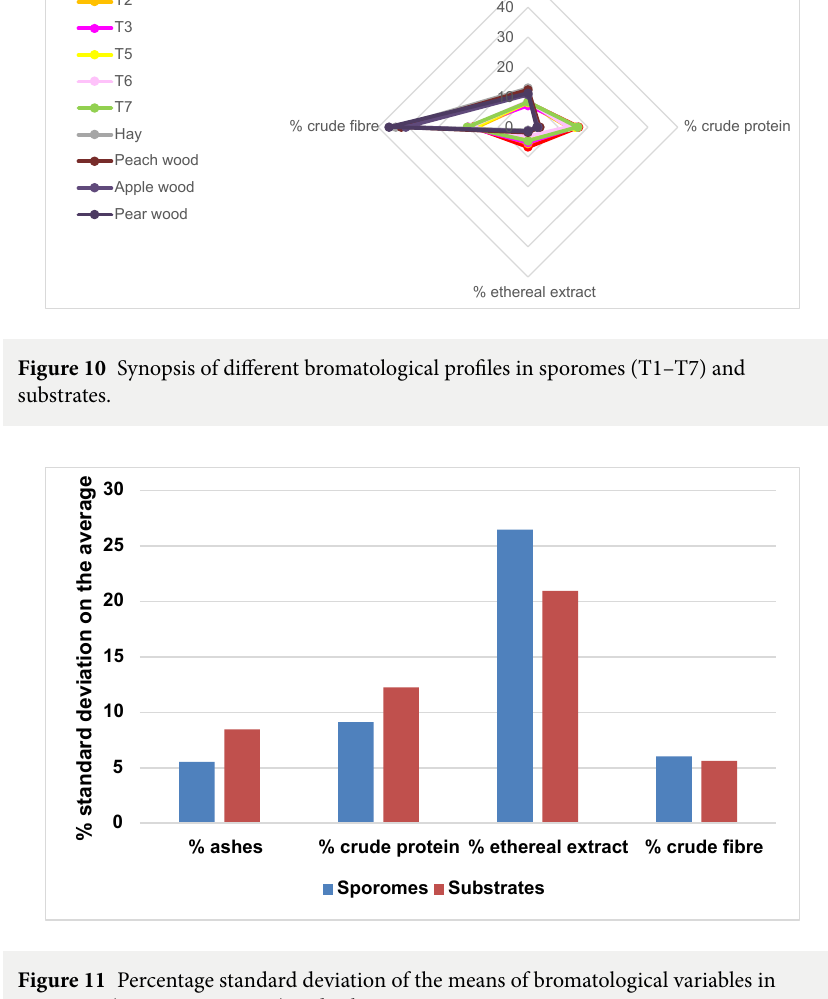
Figure 11 Percentage standard deviation of the means of bromatological variables in sporomes (among treatments) and